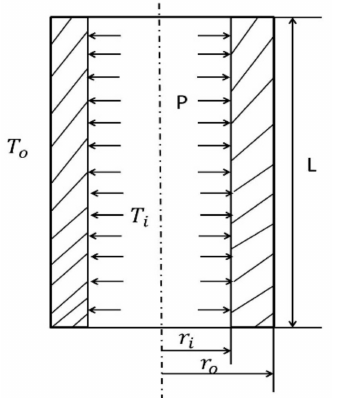
Figure 1. Schematic diagram of the axisymmetric pipe section.